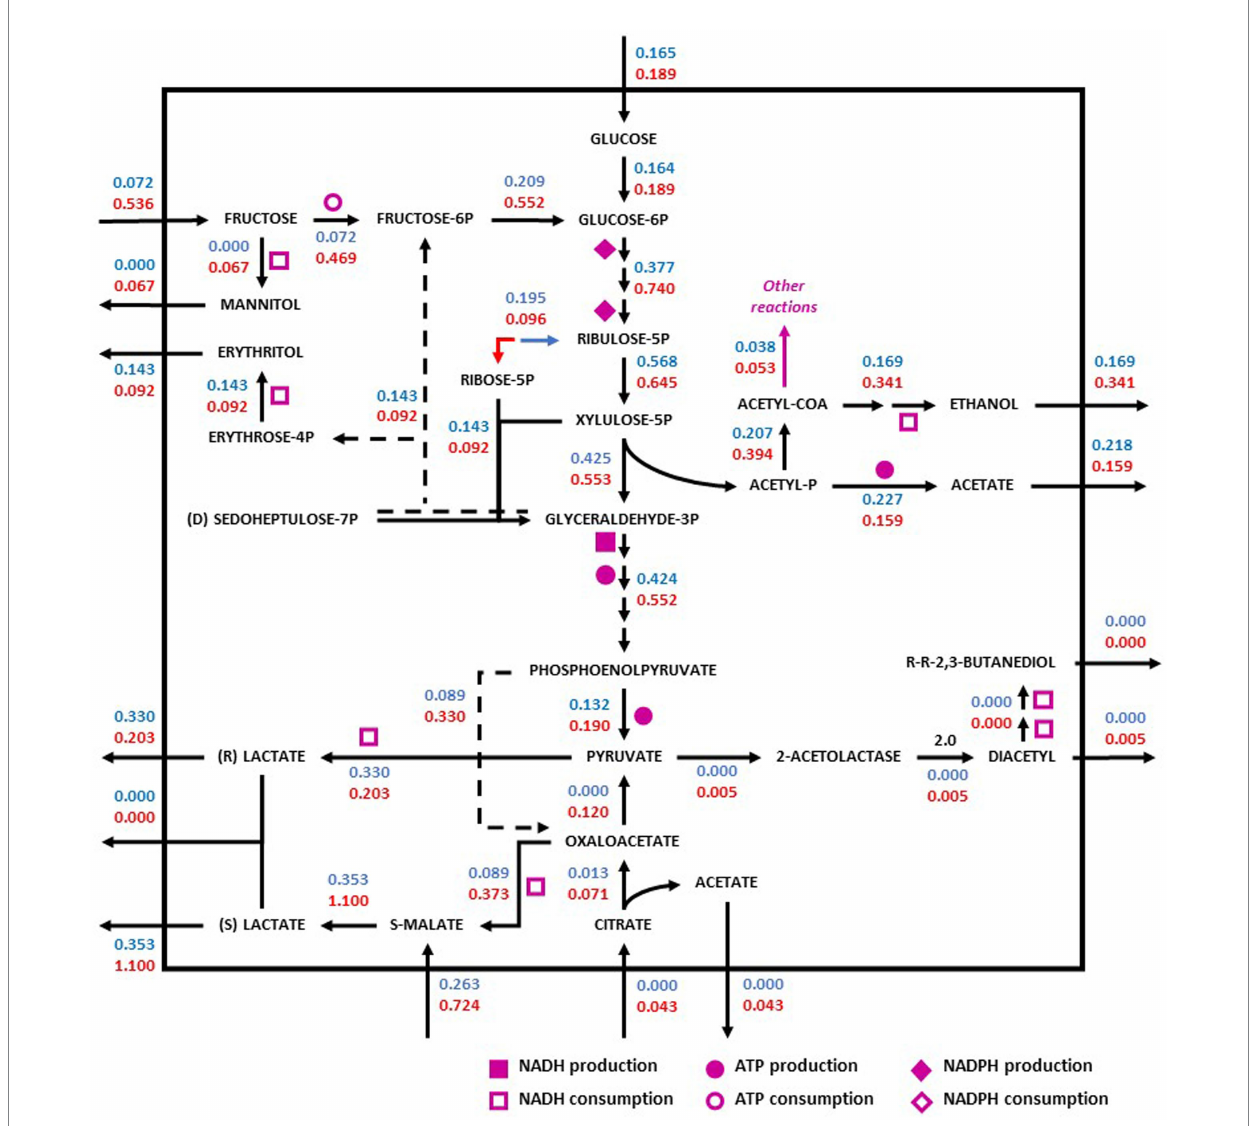
FIGURE 4 Redistribution of the metabolic flux of the strains O. oeni PSU-1 (blue) and O. oeni E1 (red) evaluated using Cabernet Sauvignon. Square, circle, and diamond polygons indicate consumption (or production) of NADH, ATP, and NADPH, respectively. S-malate corresponds to L-malate. S-and R- lactate correspond to L-and D lactate,